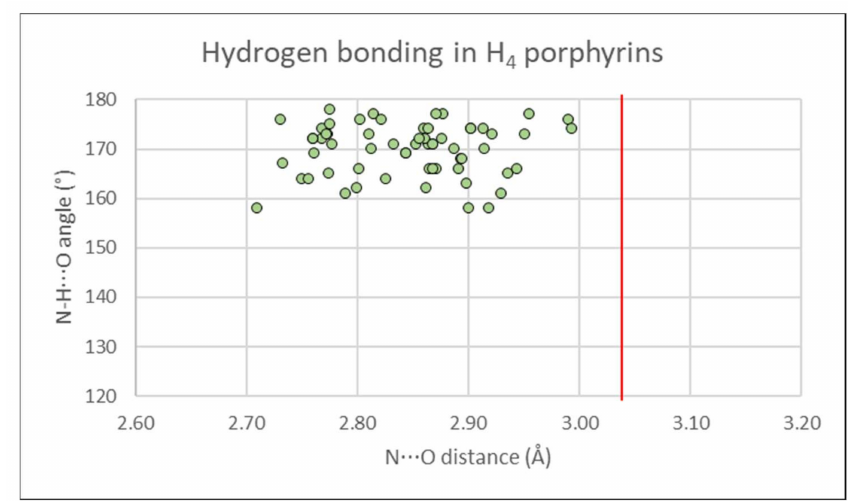
Figure 10. Donor-acceptor distances (2.7–3.0 Å) and D-H ··· X angles ( > 155 ◦ ) from porphyrin dication molecules to the counter-anions which balance the charge, in hydrogen-bonding chelates in the crystal structures reported in this paper. A red line indicates the sum of the Van der Waals radii for N and O (3.02